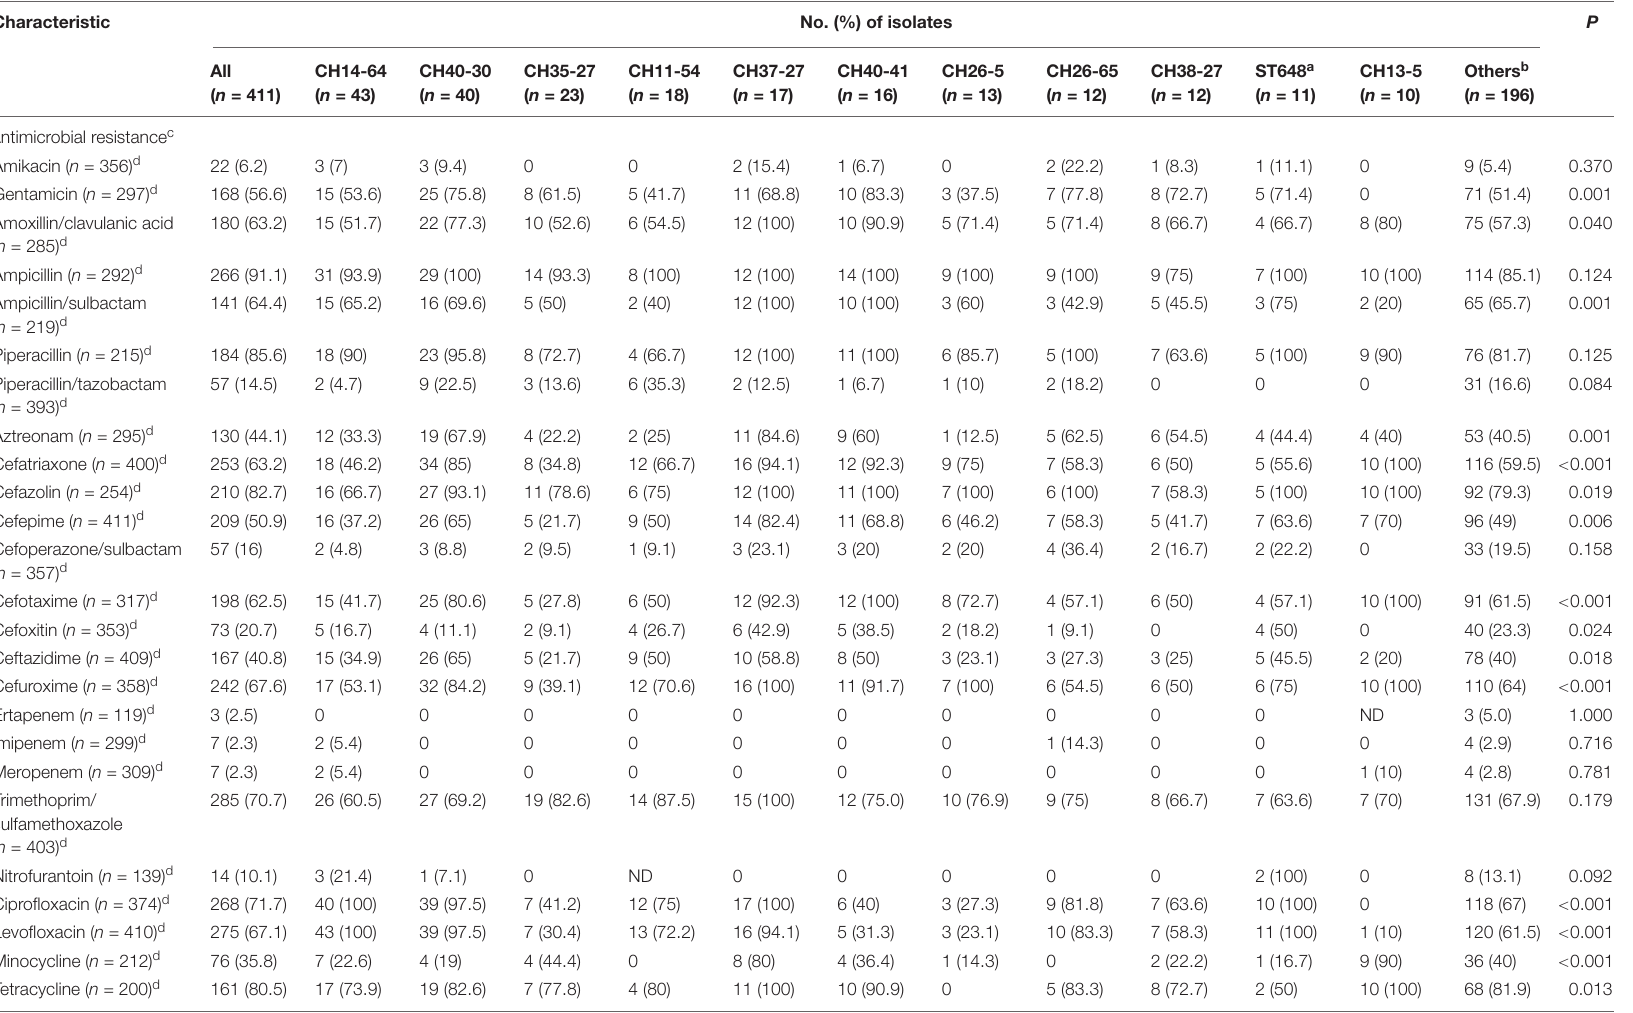
TABLE 1 | Antimicrobial resistance according to CH or ST types among the 411 ExPEC isolates.